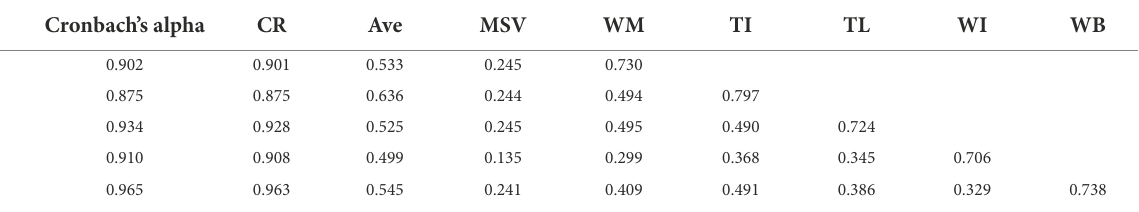
TABLE 5 Convergent and discriminant validity.